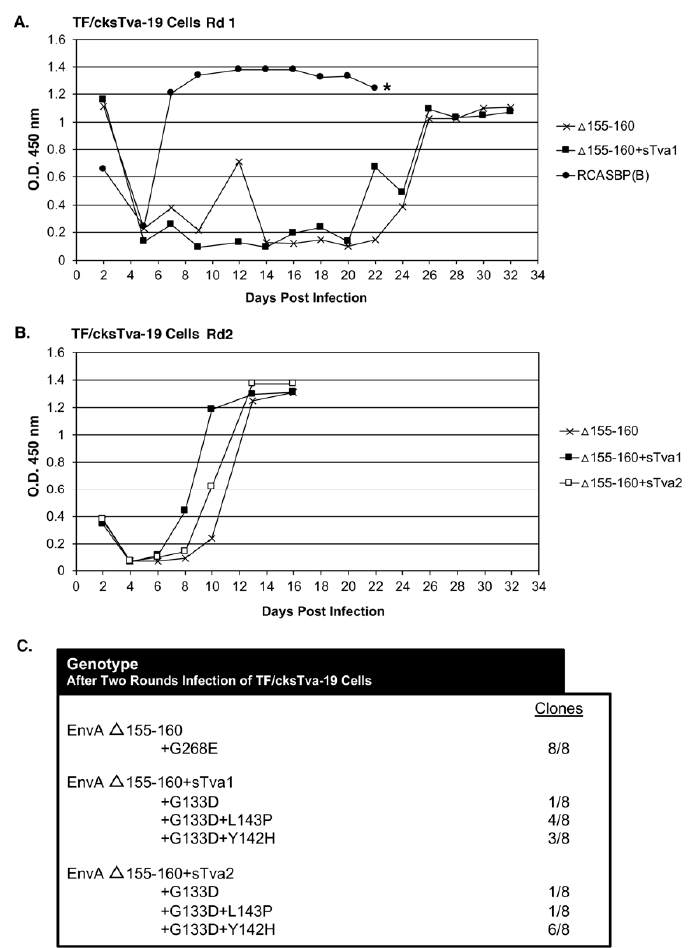
Figure 2. Evolution of RCASBP(A) Δ 155-160 virus variants resistant to cksTva-mIgG. ( A ) TF/cksTva- 19 cells expressing high levels of chicken sTva-mIgG protein were infected with DF-1 infection supernatant (10 mL) containing RCASBP(A) Δ 155–160 virus (~10 5 ifu/mL) either neat ( Δ 155–160) or